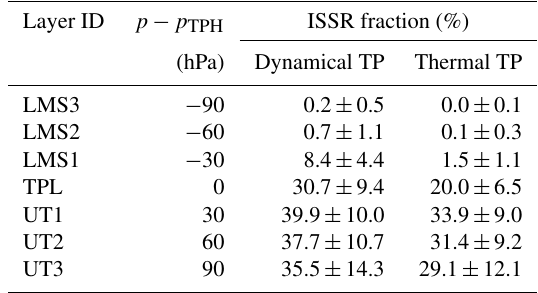
Table 3. Mean and standard deviation of seasonal fraction of ice- supersaturated regions (ISSRs) for the seven vertical layers dis- tributed around the thermal and dynamical